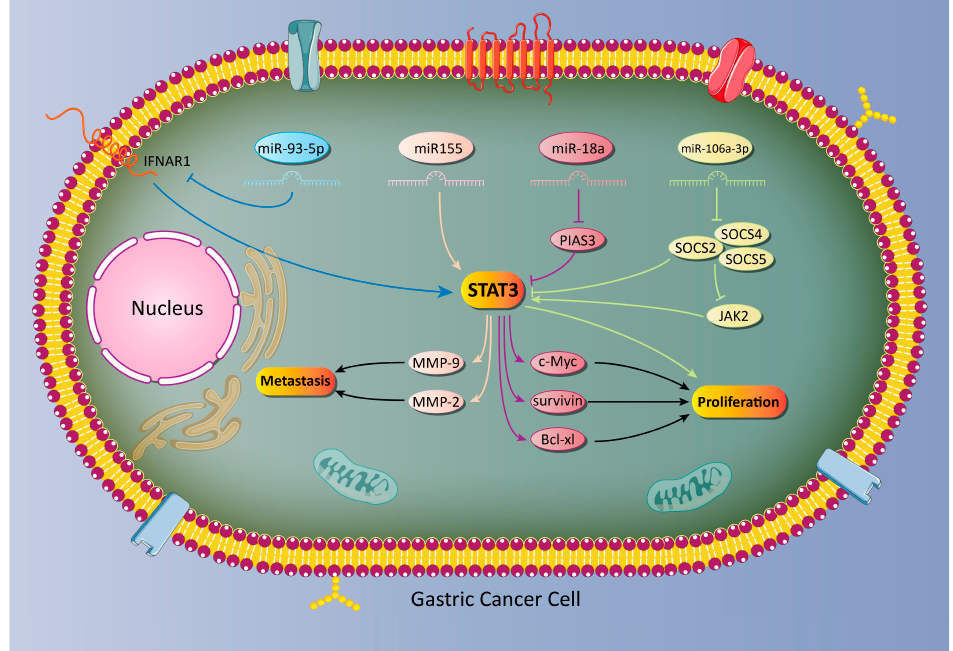
Figure 3. Oncogene miRs that activate the STAT3 signaling pathway and promote the proliferation and invasion of GC cells.